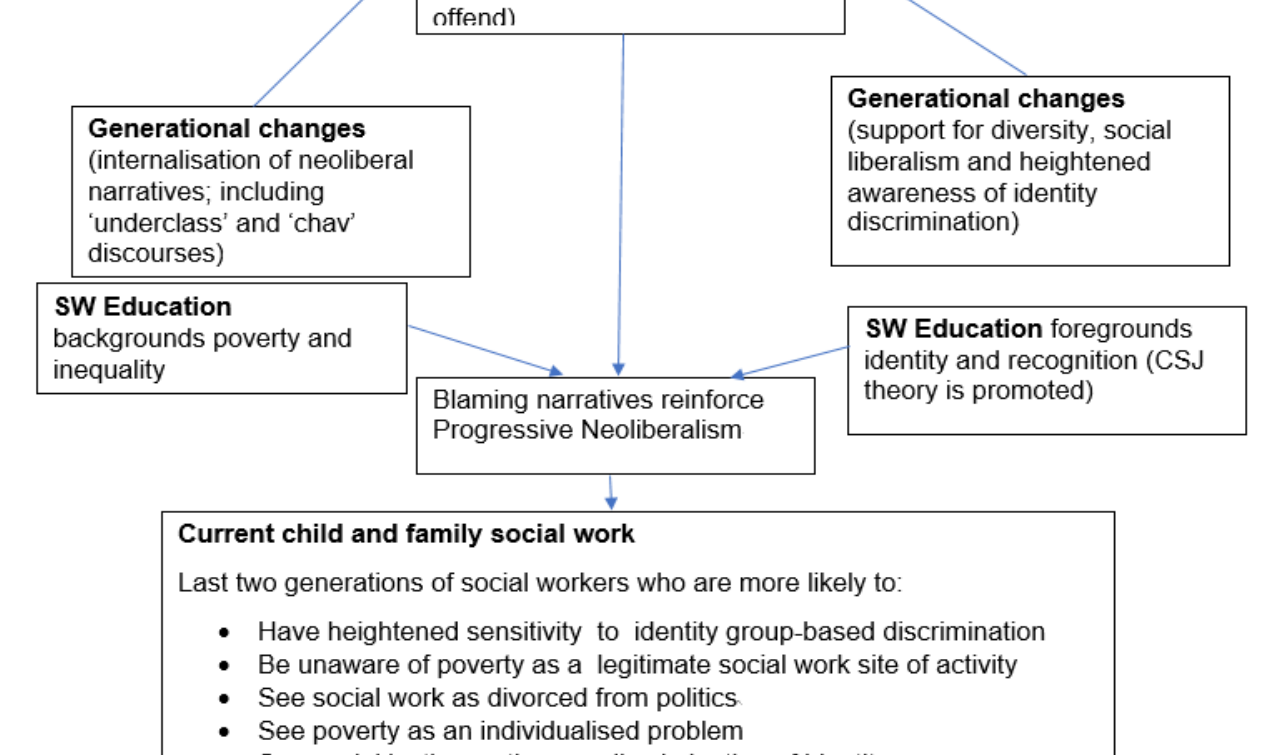
Figure 1. Author’s Own Model. 150